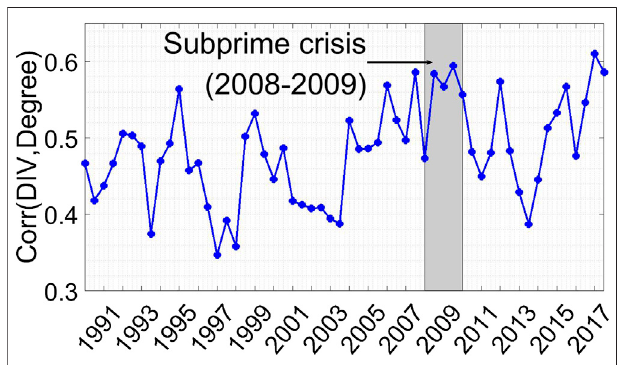
FIGURE 4 | This fi gure shows the correlation between diversi fi cation (DIV) and the degree of the PMFG network during the sample period of six months. Gray shadows represent recessions as measured as the subprime mortgage crisis periods during